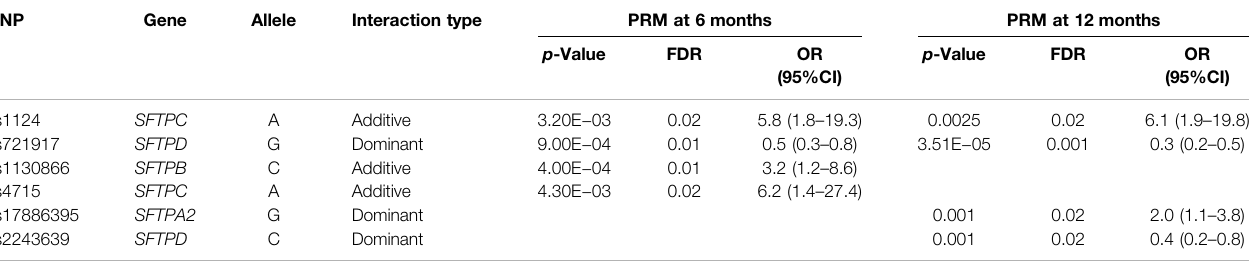
TABLE 3 | Association of surfactant protein (SP) gene single-nucleotide polymorphisms (SNPs) with persistent respiratory morbidity (PRM) at 6 and 12 months in a single- SNP model after adjusting for covariates (age, sex, race, and